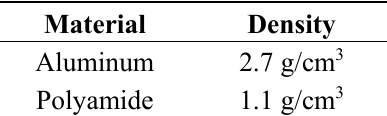
Table 12. Material